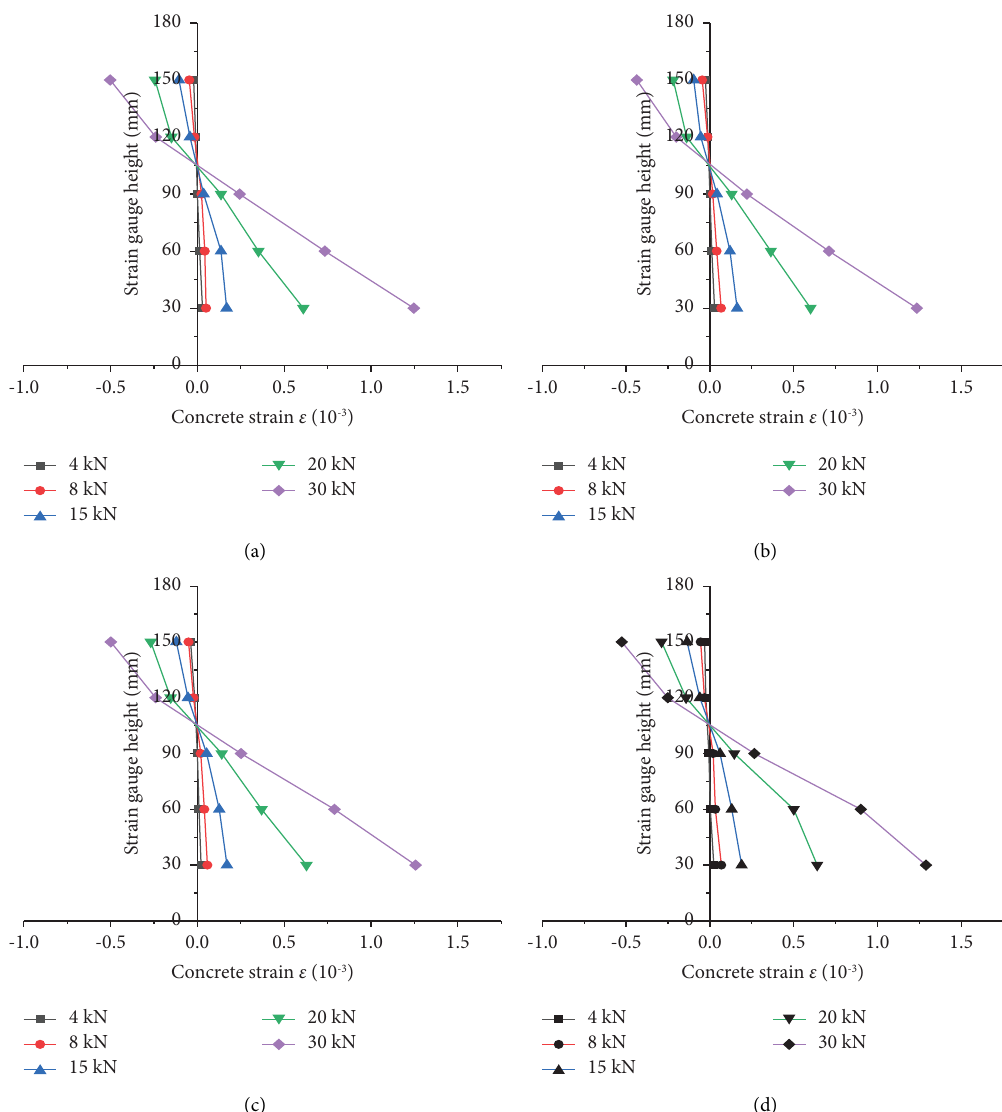
Figure 8: Strain distribution of diferent section heights in the middle of the test beam in a freshwater environment. (a) FE-10; (b) FE-20; (c) FE-30; and (d)